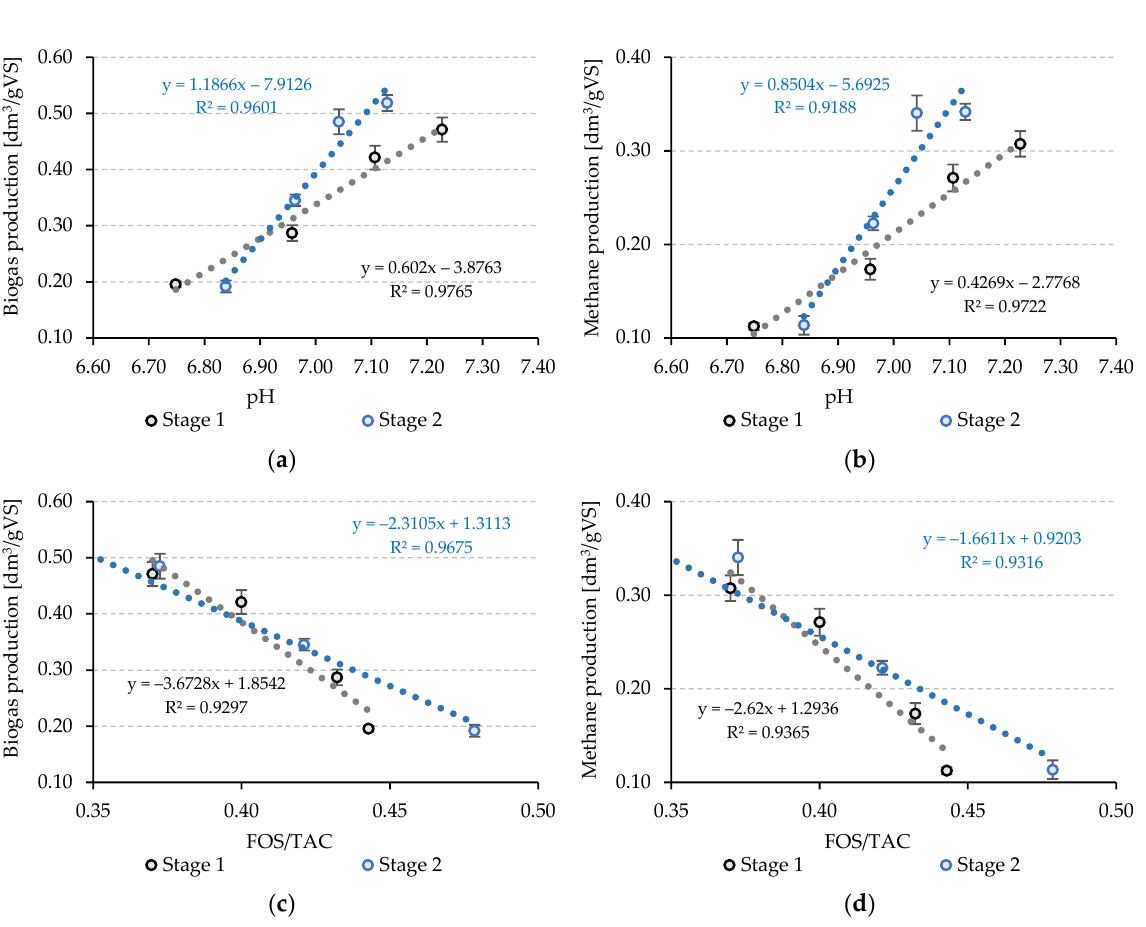
Figure 7. Correlations between pH and the yields of biogas ( a ) and methane ( b ); as well as between FOS/TAC and the yields of biogas ( c ) and methane ( d ).